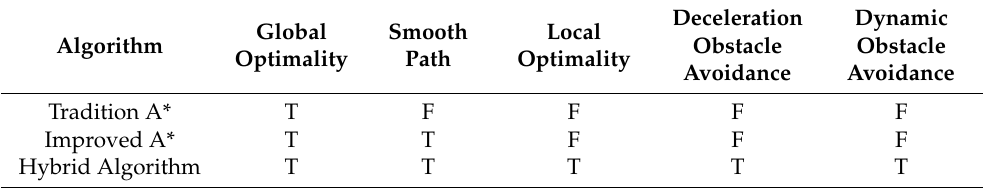
Table 4. Comparison of algorithms in this